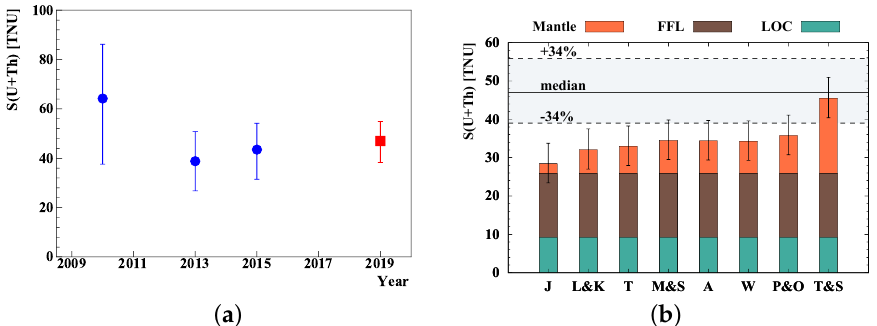
Figure 16. ( a ) Comparison of the geoneutrino signal S geo (U+Th) at LNGS as measured by Borexino. Blue circles indicate the results from 2010 [124], 2013 [125], and 2015 [126], while the red square represents the most recent result from 2019 [19]. ( b ) Comparison of the expected geoneutrino signal S geo (U+Th) at LNGS (calculated according to different BSE models) with the Borexino measure- ment [19]. For each model, the bulk lithosphere contribution (LOC+FFL) is the same, while the mantle signal, obtained considering an intermediate scenario, varies. The horizontal solid back line represents the median geoneutrino signal S med geo , while the gray band represents the 68% coverage interval. From [19].